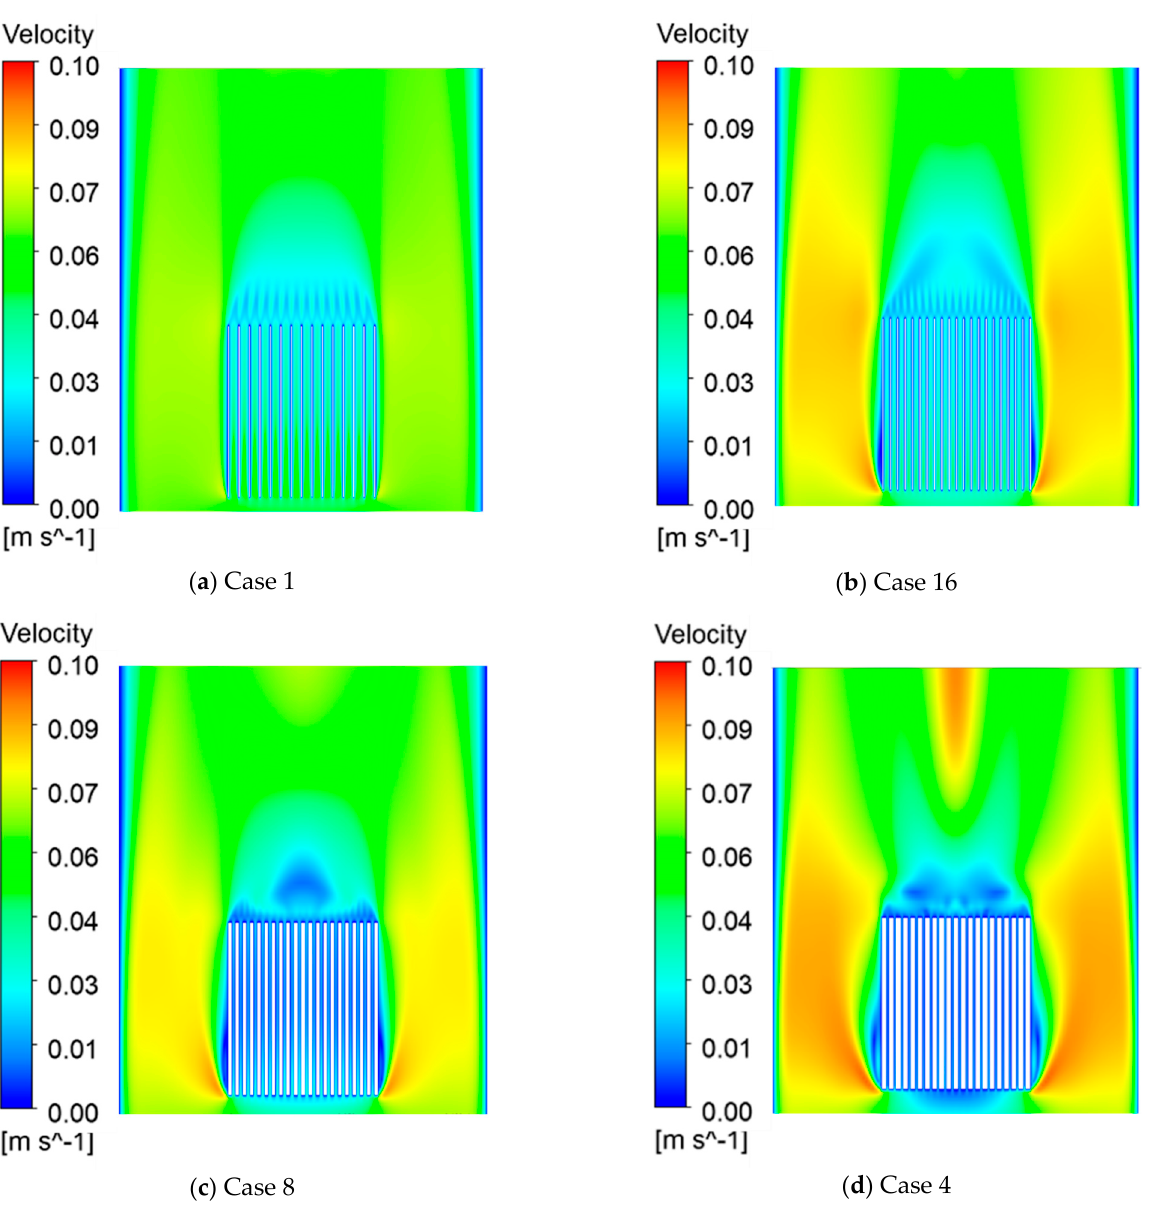
Figure 5. Temperature display of heat sinks.